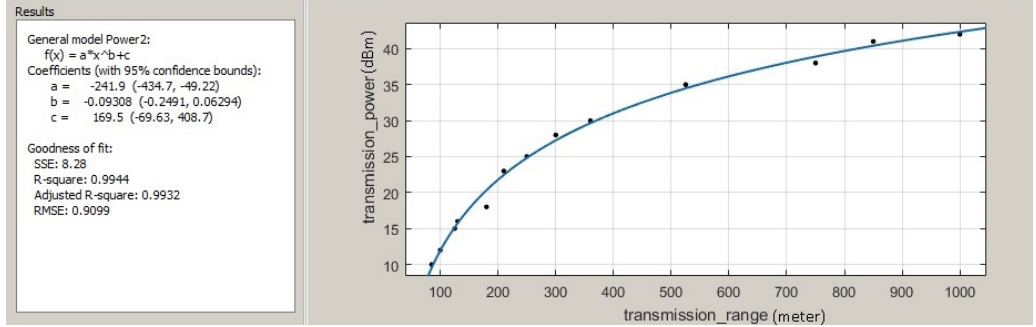
Figure 6. Transmission power